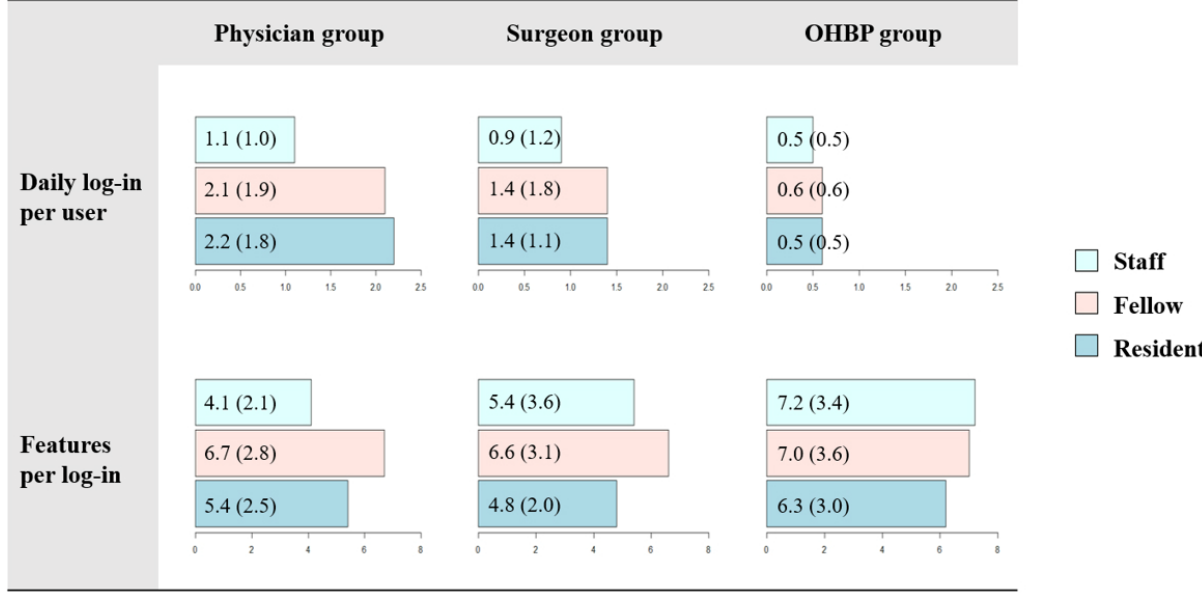
Figure 4. The average numbers of daily log-ins per user and features per log-in according to users’specialty and position. The numbers in parentheses stand for standard deviation. OHBP: other hospital-based physician.